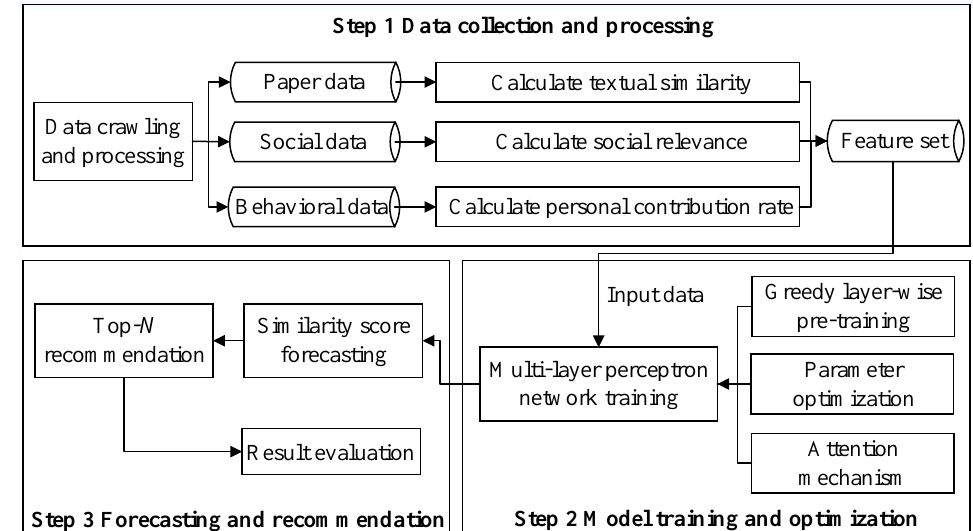
Figure 1. Mul-RSR